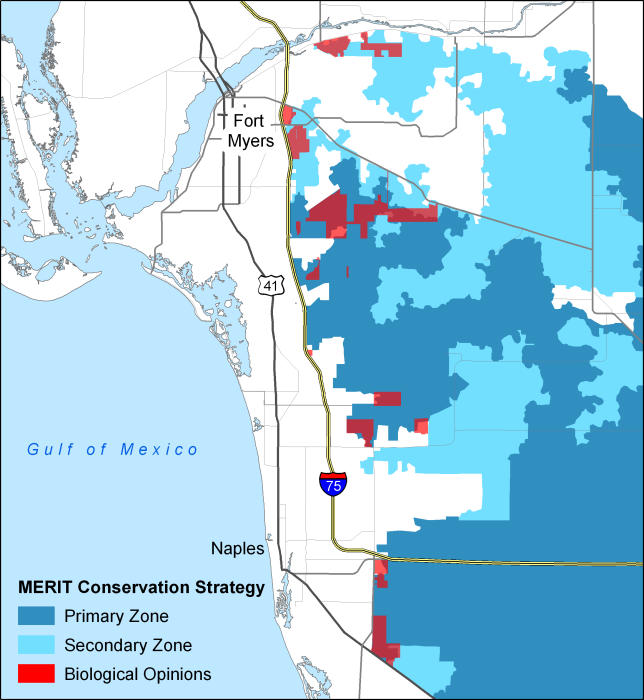
Development Projects in Panther Habitat Since 2000In a 2002 landscape conservation strategy, members of the MERIT panther recovery subteam identified lands essential to the long-term survival of the Florida panther. The MERIT subteam defined the Primary Zone (dark blue) as “all lands essential for the survival of the Florida panther in the wild.” The Secondary Zone (light blue) includes “lands contiguous with the Primary Zone, and areas which panthers may currently use, and where expansion of the Florida panther population is most likely to occur.” Maintaining the integrity and connectivity of the Primary Zone, which includes both public and private lands, is one of the highest priorities for panther survival, the subteam determined. It also stressed the importance of avoiding “land-use intensification” in the Secondary Zone, as well as in areas that panthers use to disperse. Yet development continues. Since 2000, the FWS has written 27 biological opinions (red) evaluating the impacts of Florida development projects in panther habitat. (This map does not include biological opinions written in 2005.)(Illustration: Brad Nunley/National Wildlife Federation)